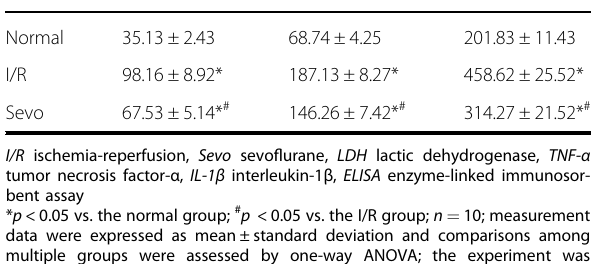
Table 2 ELISA con fi rms LDH, TNF- α , and IL-1 β are increased in mice with I/R injury after TKA